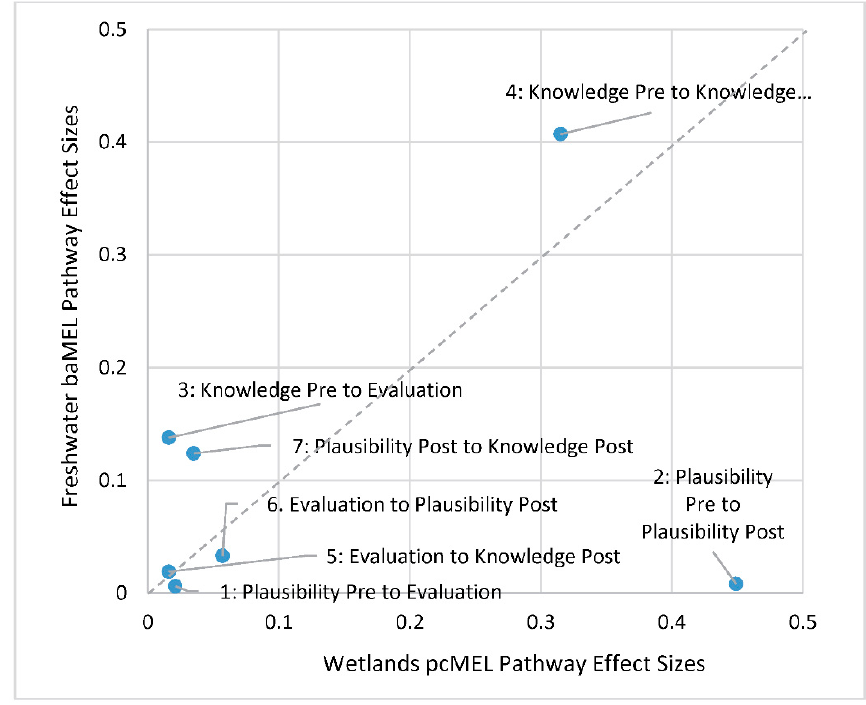
Figure 8. Comparison of pathway e ff ect sizes between the Wetlands pcMEL and the Freshwater baMEL. Pathway e ff ect size values are unbiased indices that are compatible with PLS-SEM and essentially equivalent to Cohen’s f 2 coe ffi cient [34], with small e ff ect size = 0.02, medium e ff ect size = 0.15, and large e ff ect size = 0.35. The dashed line indicates when e ff ect sizes are equivalent in the two MELs. Points above and to the left of the dashed line indicated when e ff ects sizes are greater for the Freshwater baMEL. Points below and to the right of the dashed line indicate when e ff ect sizes are greater for the Wetlands pcMEL.